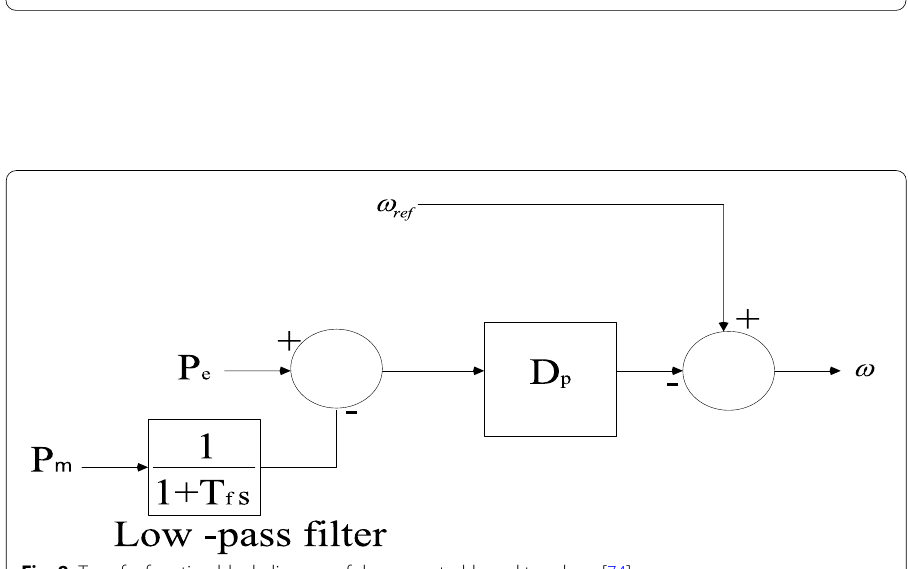
Fig. 8 Transfer function block diagram of droop control-based topology